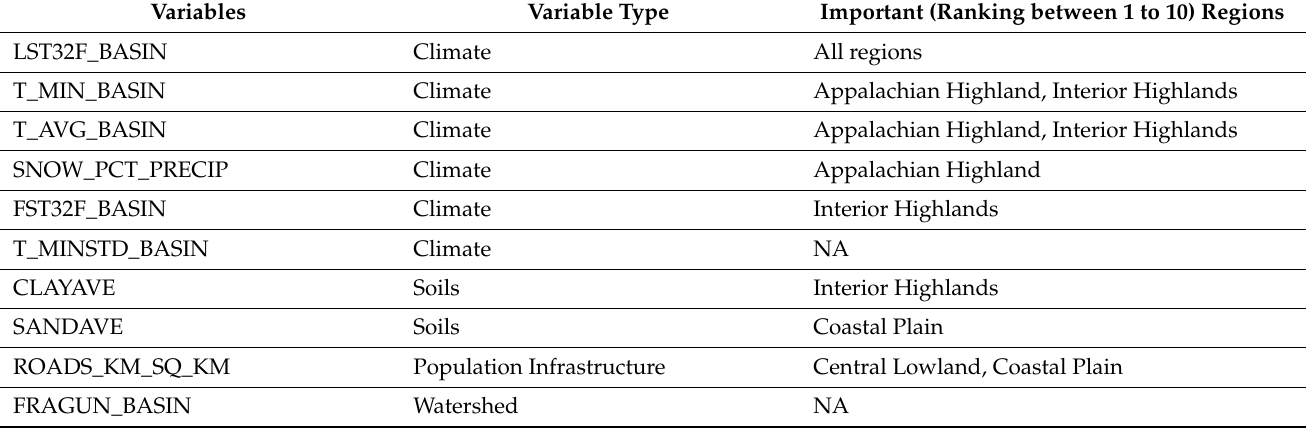
Table 2. Types of most important (ranking 1 to 10) predictor variables across different physio- graphic regions. Description of predictor variables is provided in Appendix A.